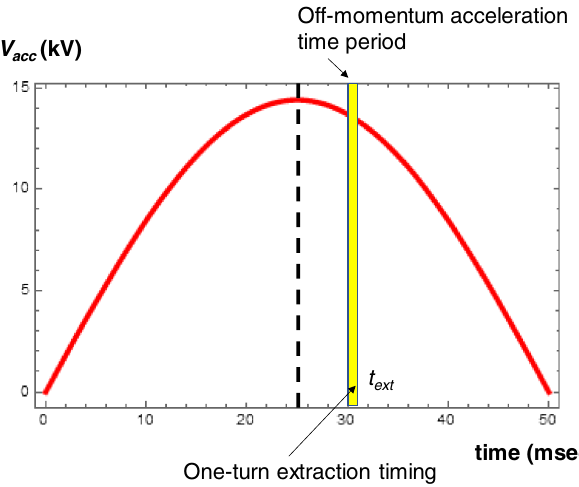
FIG. 3. Required acceleration voltage profile and off-momen- tum deceleration time period (yellow).